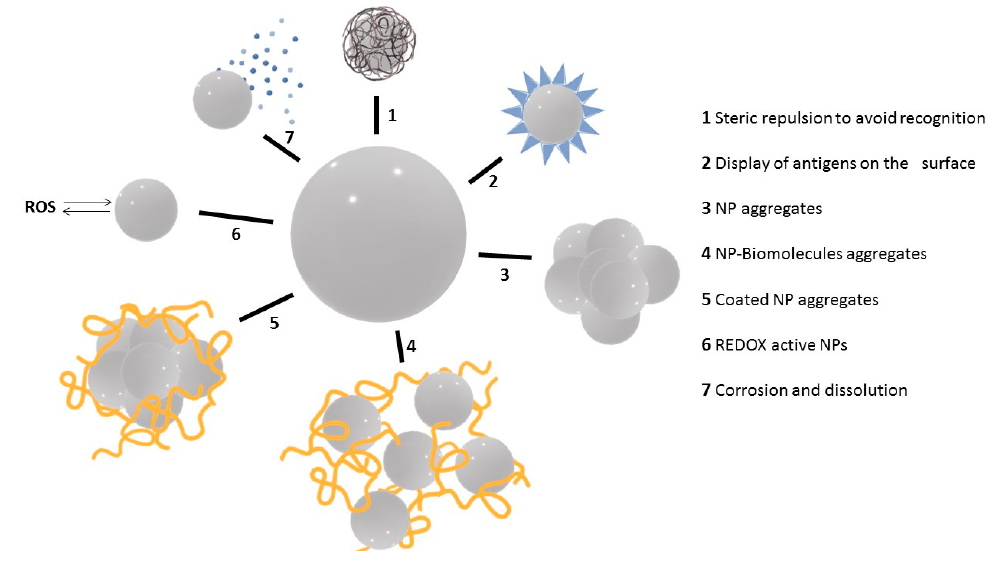
Figure 3. Intended or spontaneous NP modifications and their impact on immune responses.